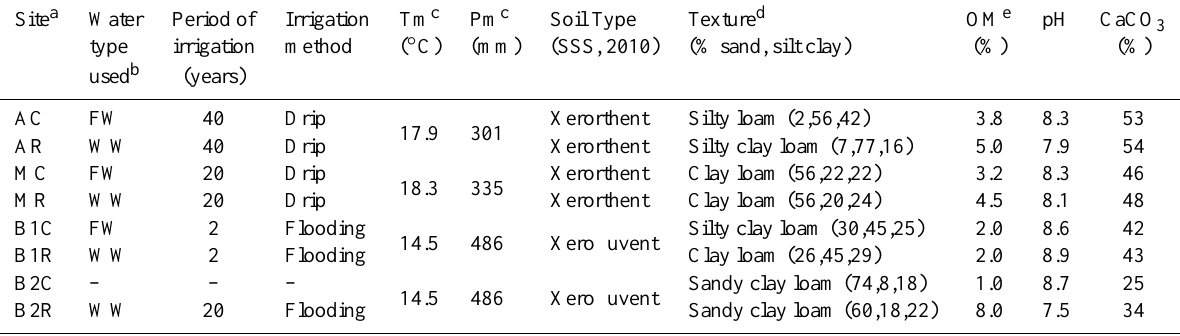
Table 1. Study sites, irrigation methods, climatic parameters and soil characteristics. Site a